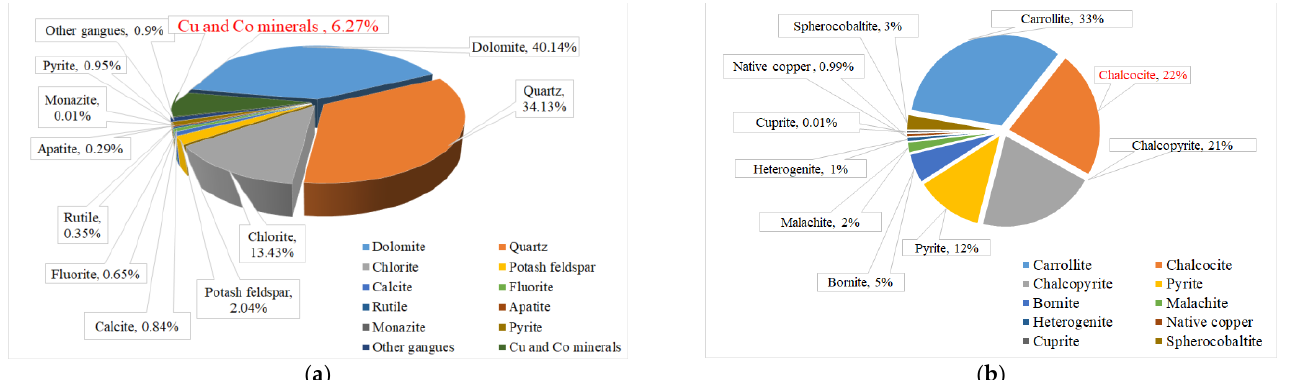
Figure 2. Mineral type and composition of ore. ( a ) Mineral composition of ore ( b ) Mineral composition of metallic minerals.